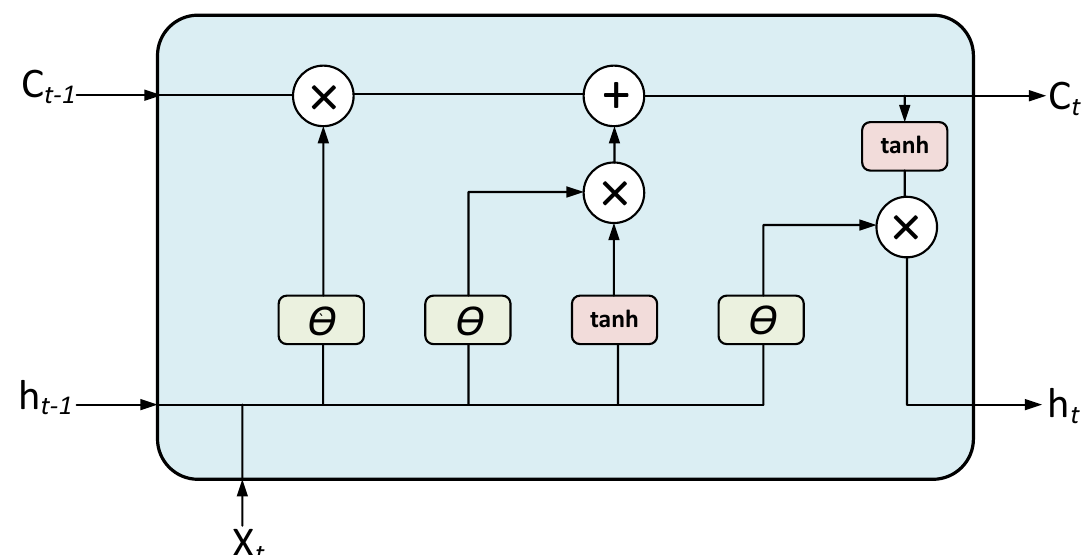
Figure 2. Basic flow of process of LSTM for time-series prediction